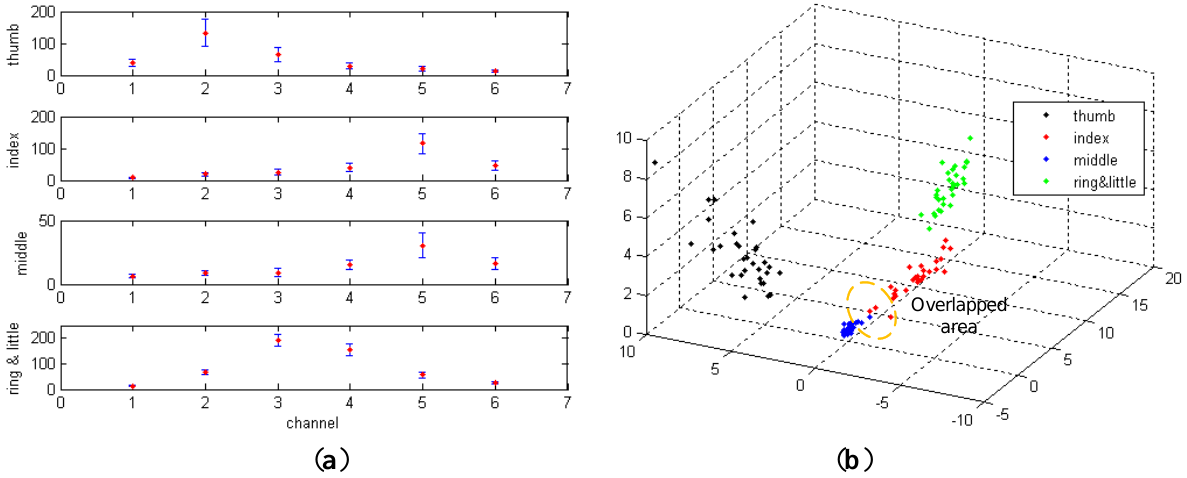
Figure 5. ( a ) Raw square integral features of the four gestures. ( b ) Projected square integral features of the four